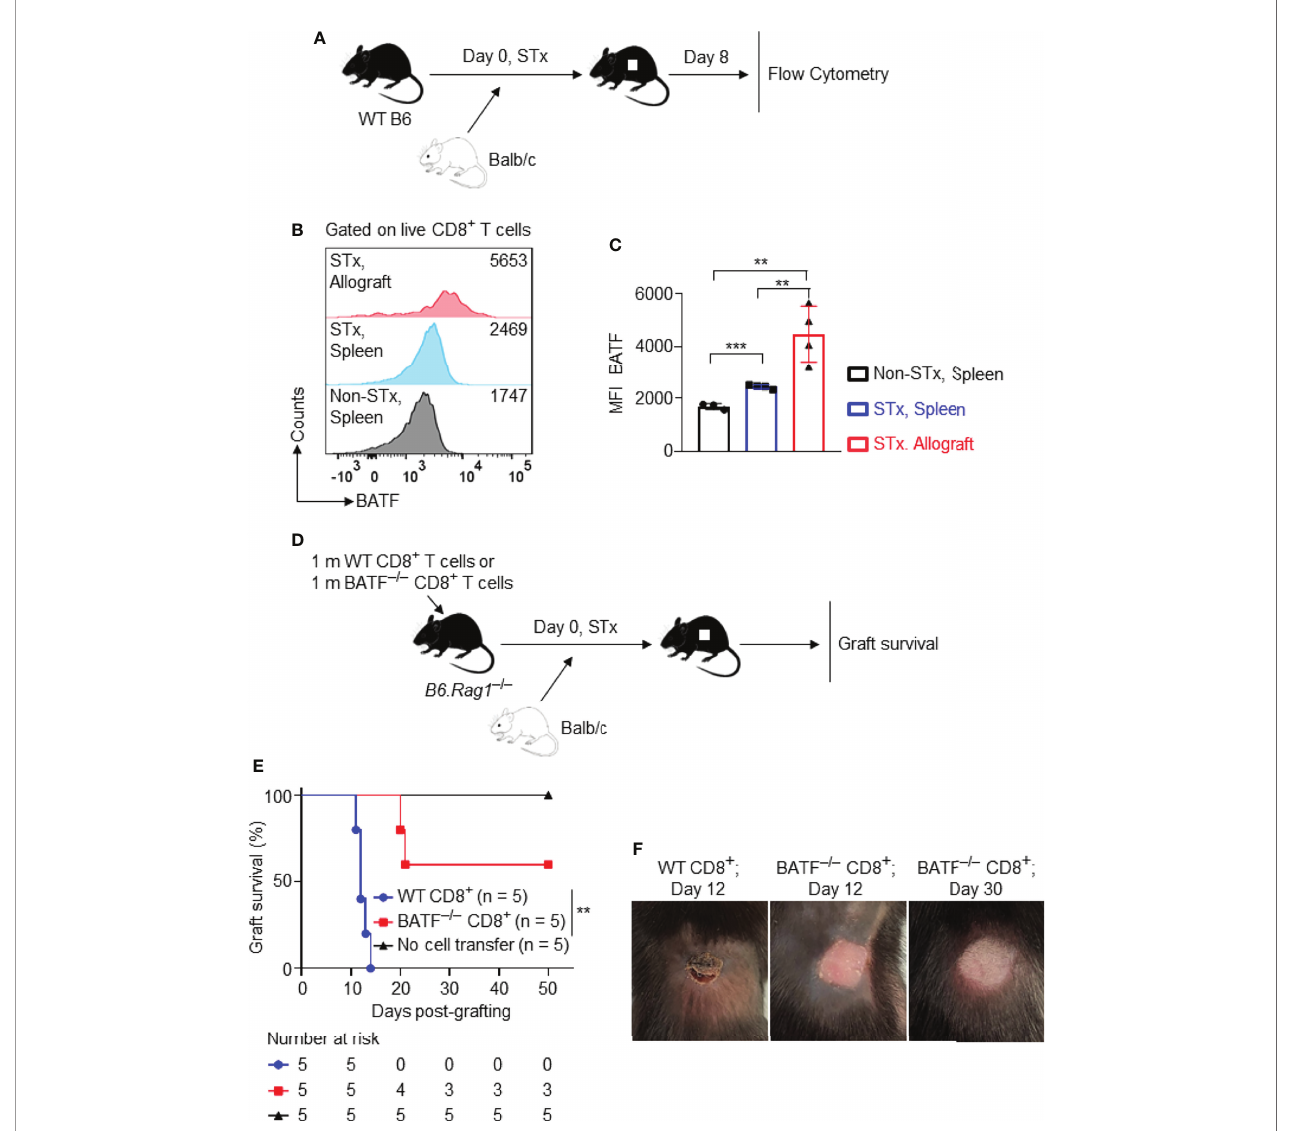
FIGURE 1 | Graft-in fi ltrating CD8 + T cells highly express BATF, and BATF de fi ciency in CD8 + T cells prolongs skin allograft survival. Wild-type B6 recipients were transplanted with Balb/c skin allografts or left untransplanted on day 0. The expression levels of BATF in CD8 + T cells in these recipients were detected by fl ow cytometry on day 8 post skin grafting. All plots were gated on live CD8 + T cells. (A) Schematic of the experimental design. (B, C) Representative plots and bar graphs display the BATF expression levels in CD8 + T cells from spleens and skin allografts. Data represent the mean ± SD (n = 3-4). ** p < 0.01, *** p < 0.001; (unpaired Student ’ s t -test). B6. Rag1 – / – hosts were adoptive transferred with either 1 x 10 6 WT CD8 + T cells or 1 x 10 6 BATF – / – CD8 + T cells, followed by Balb/c skin transplantation. (D) Schematic of the experimental design. (E) % skin allograft survival (n = 5). ** p < 0.01; (Mann-Whitney test). (F) Representative images of the skin allografts on B6. Rag1 – / – recipients at indicated days post skin